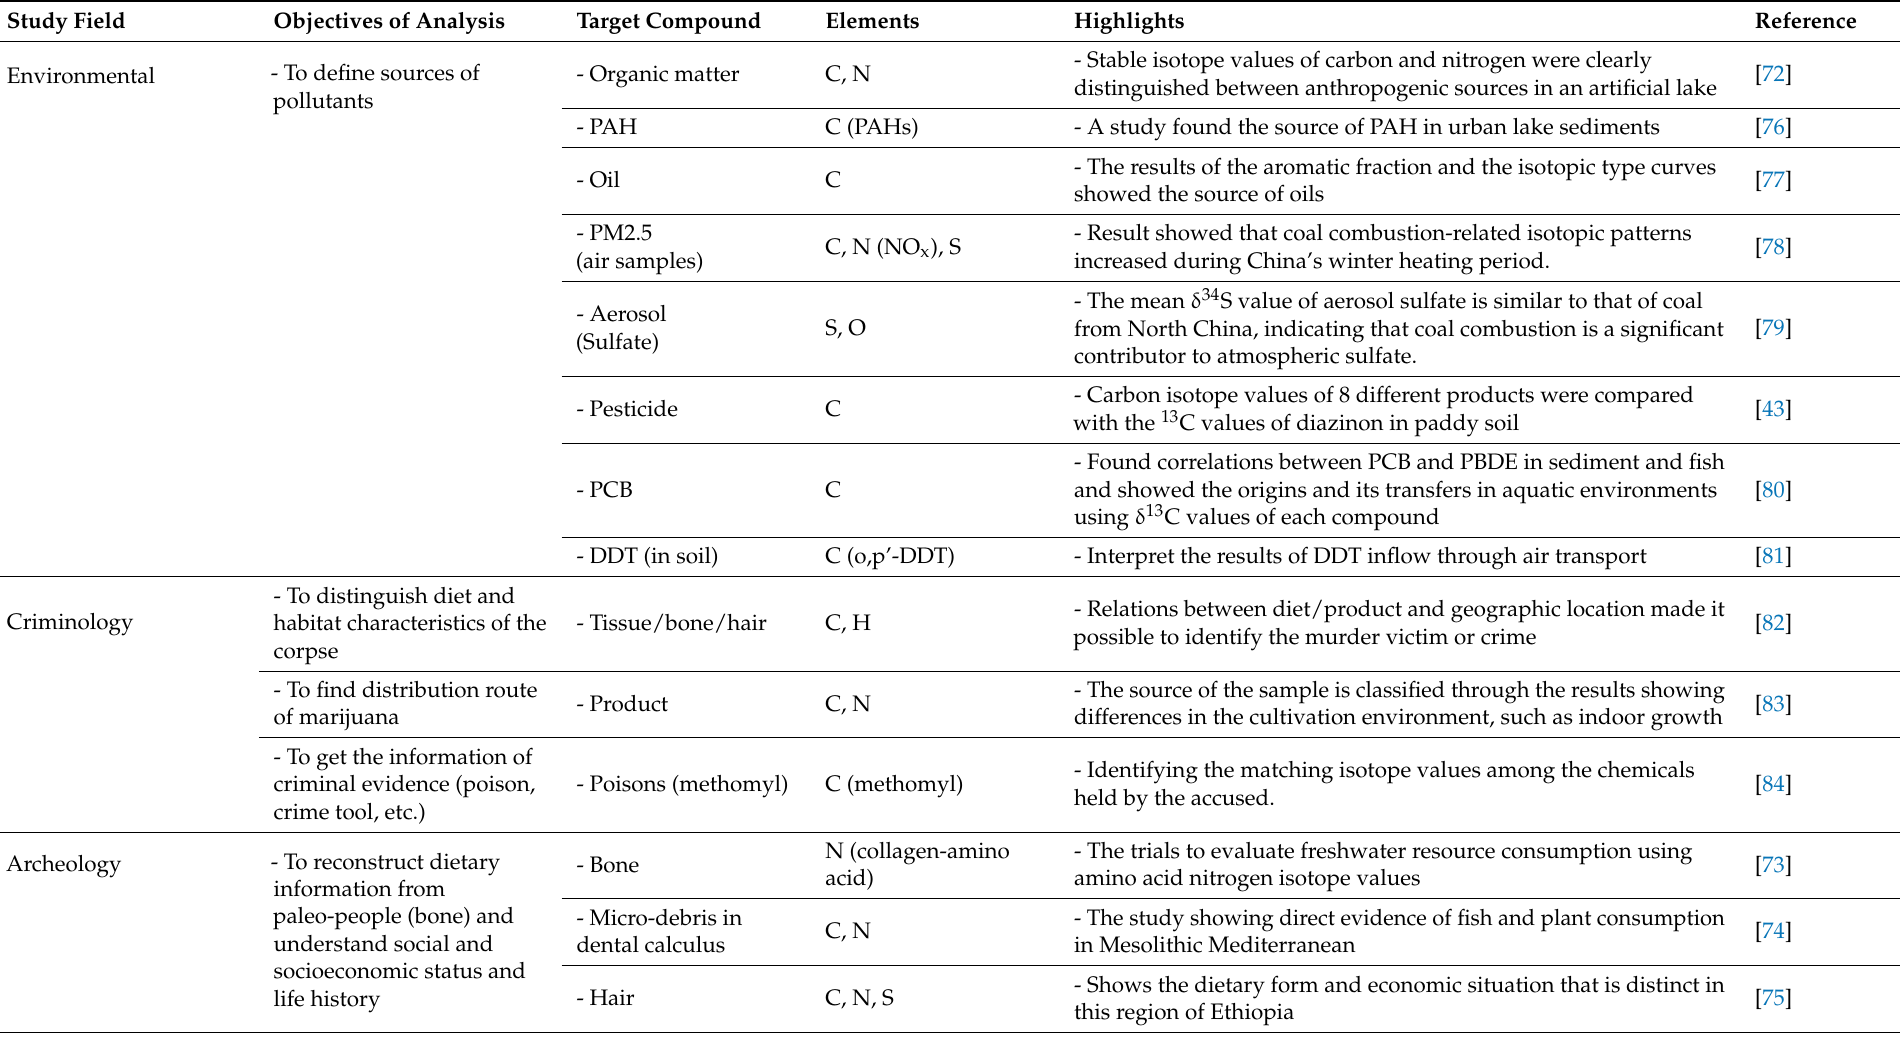
Table 1. Representative studies using stable isotope ratios of diverse analytes for forensic sciences. Examples of pesticides only listed studies on the parent compound (pesticide products). Study